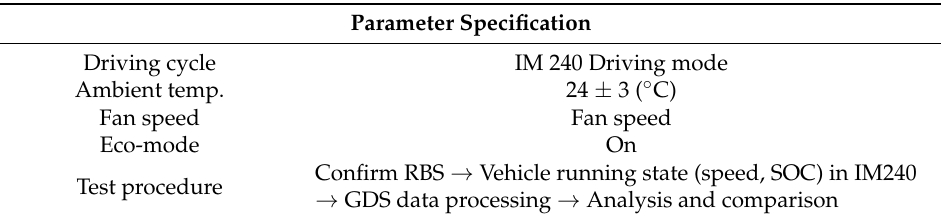
Table 3. Experimental